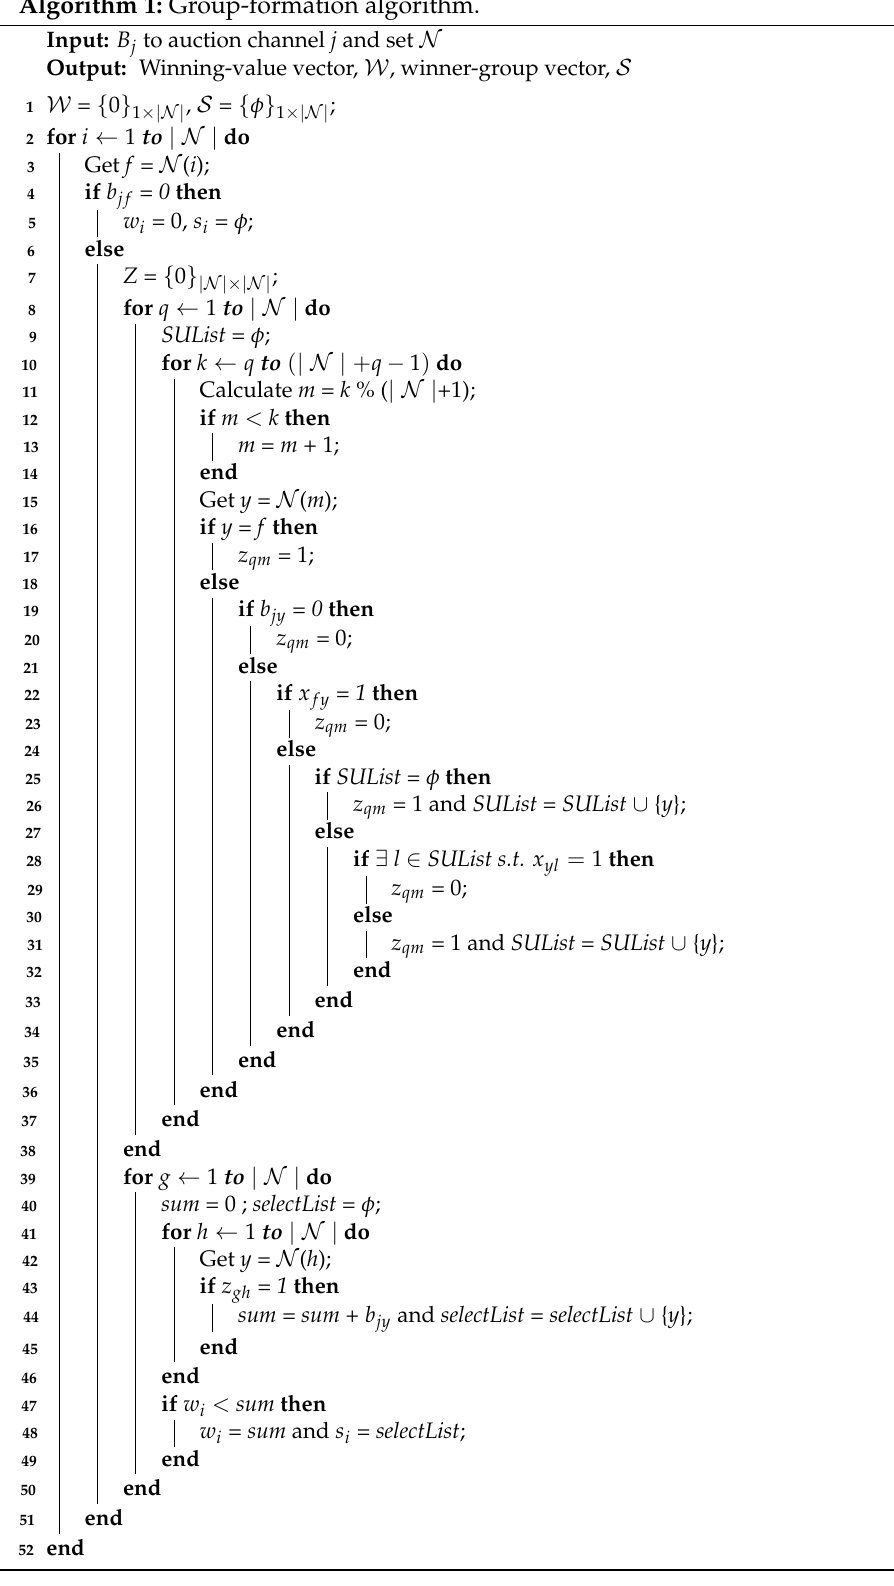
Algorithm 1: Group-formation